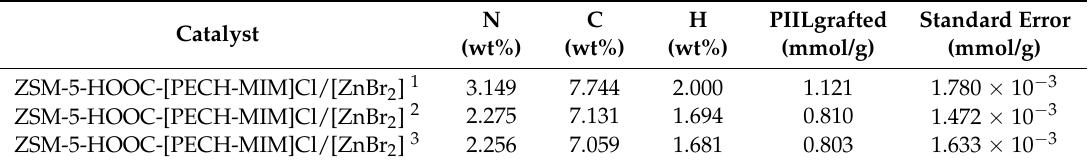
Table 3. Elemental analysis results of the